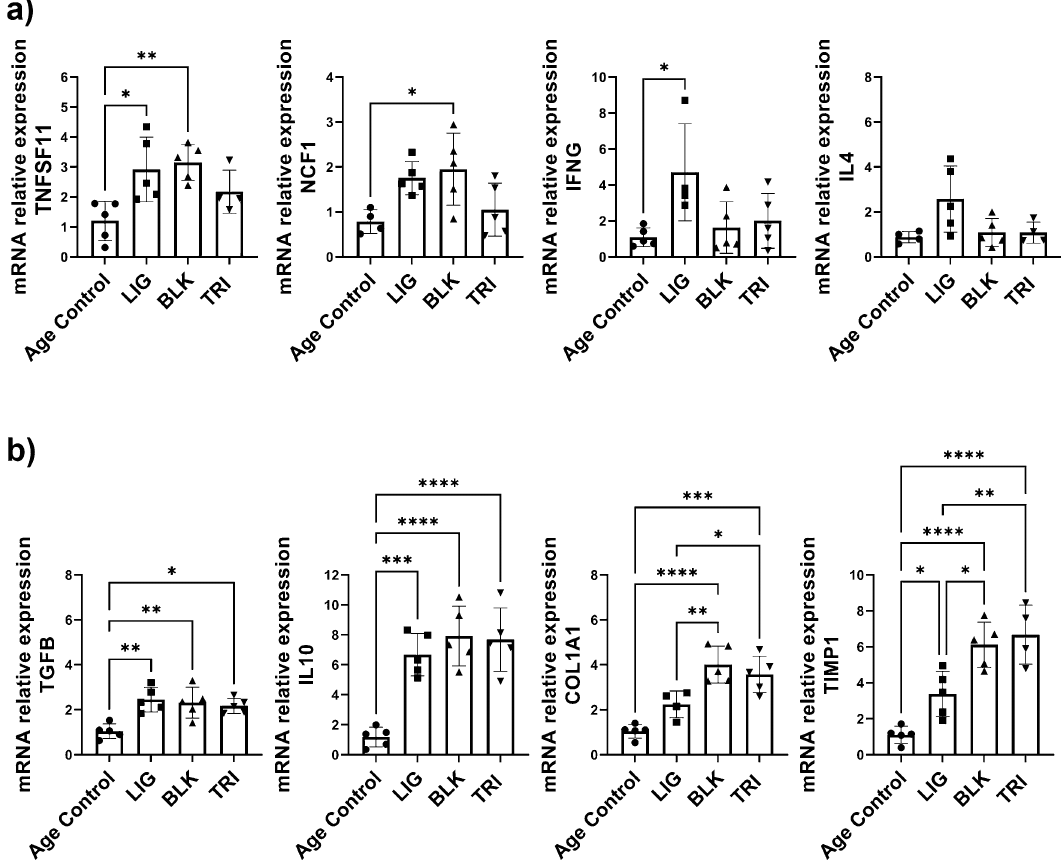
Figure 5. Expression of pro-inflammatory vs. pro-regenerative markers following treatment. Balb/c mice from Group A—ligatures applied with a TRI microsphere injection (TRI), Group B—ligatures applied with blank PLGA (vehicle only) microsphere injection (BLK), Group C—ligatures applied only (LIG) or Group D—no ligatures applied (age control) were sacrificed after 7 days. Periodontal gingival tissues were resected and mRNA expression was assed by qPCR for ( a ) markers indicative of a pro-inflammatory environment ( Tnfsf11, Ncf1, Ifnγ, and Il4 ) versus ( b ) anti-inflammatory and pro-regenerative markers ( Tgfβ, Il10, Col1a1, and Timp1 ). mRNA expression levels were compared by the value of 2 (−ΔΔCt) with Gapdh as the endogenous control. A One- way ANOVA was performed followed by Tukey post-hoc analysis to compare the mean of every group with the mean of every other group to determine statistical significance where; ** p ≤ 0.01, *** p ≤ 0.001, **** p ≤